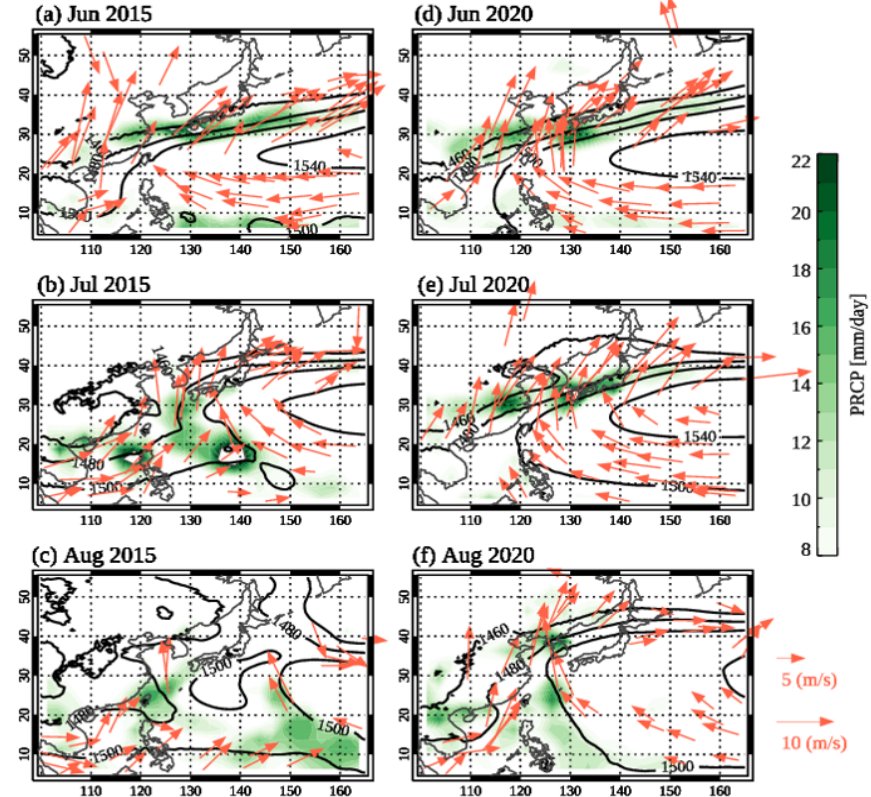
Figure 7. The monthly meteorological fields at 850hPa for (a–c) 2015 and (d–f) 2020. The wind vectors are drawn with the orange arrows. The geopotential heights are superimposed with black lines. The variations of precipitation are shown in green shades. Note that we use MERRA-2 meteorological variables except for the precipitation data taken from the GPCP Version 2.3 Combined Precipitation Data Set (Adler et al.,